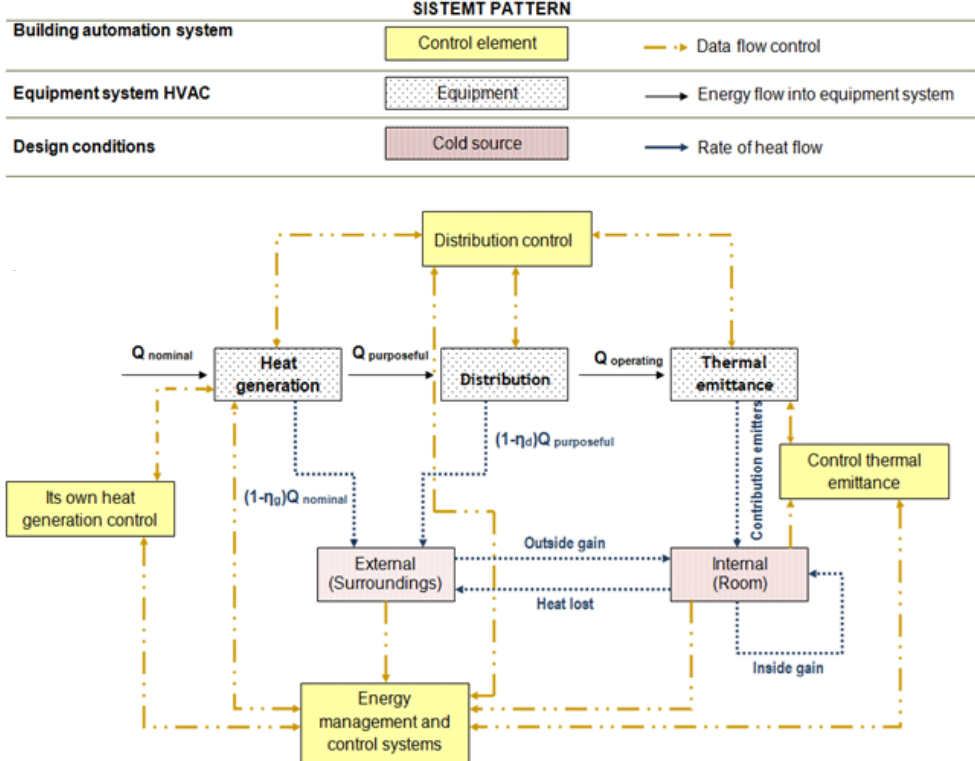
Figure 1. Block diagram of a standard heat generating